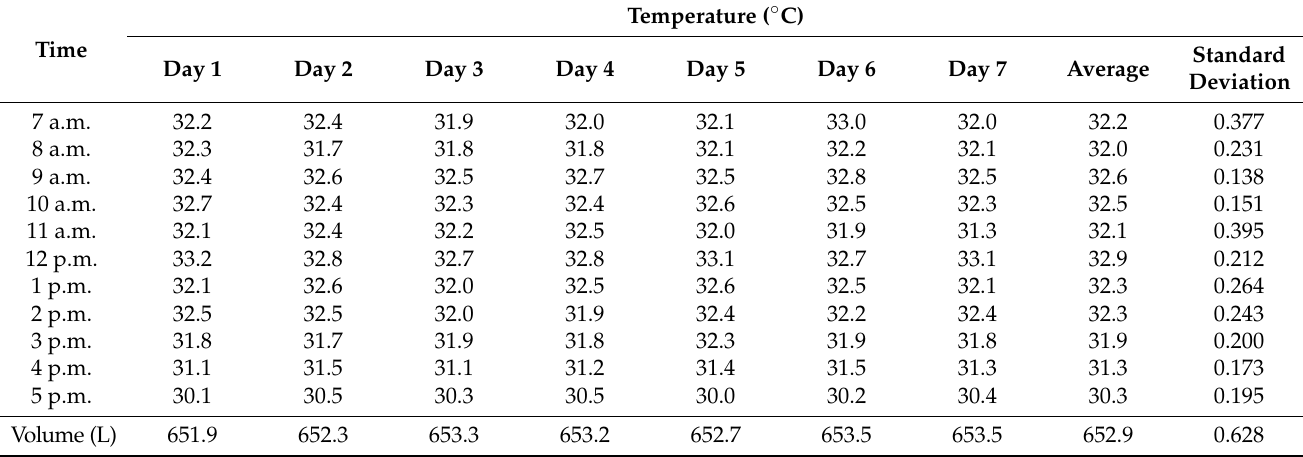
Table 8. Temperature in the greenhouse using the optimum flow rate of water